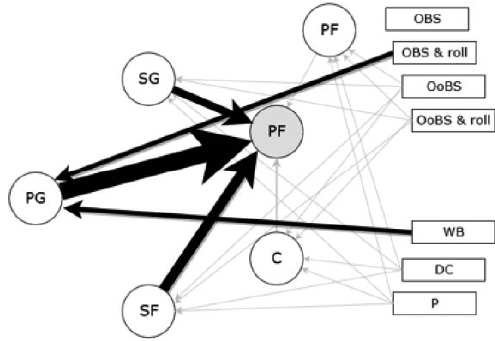
Fig. 2 The equivalent model of a football field